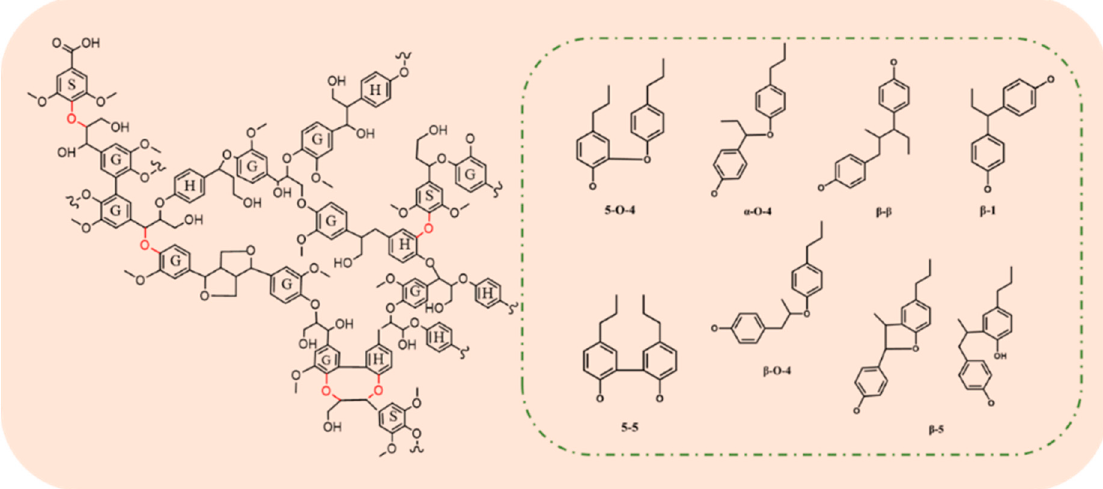
Figure 1. Structure of lignin and basic bond types between units.